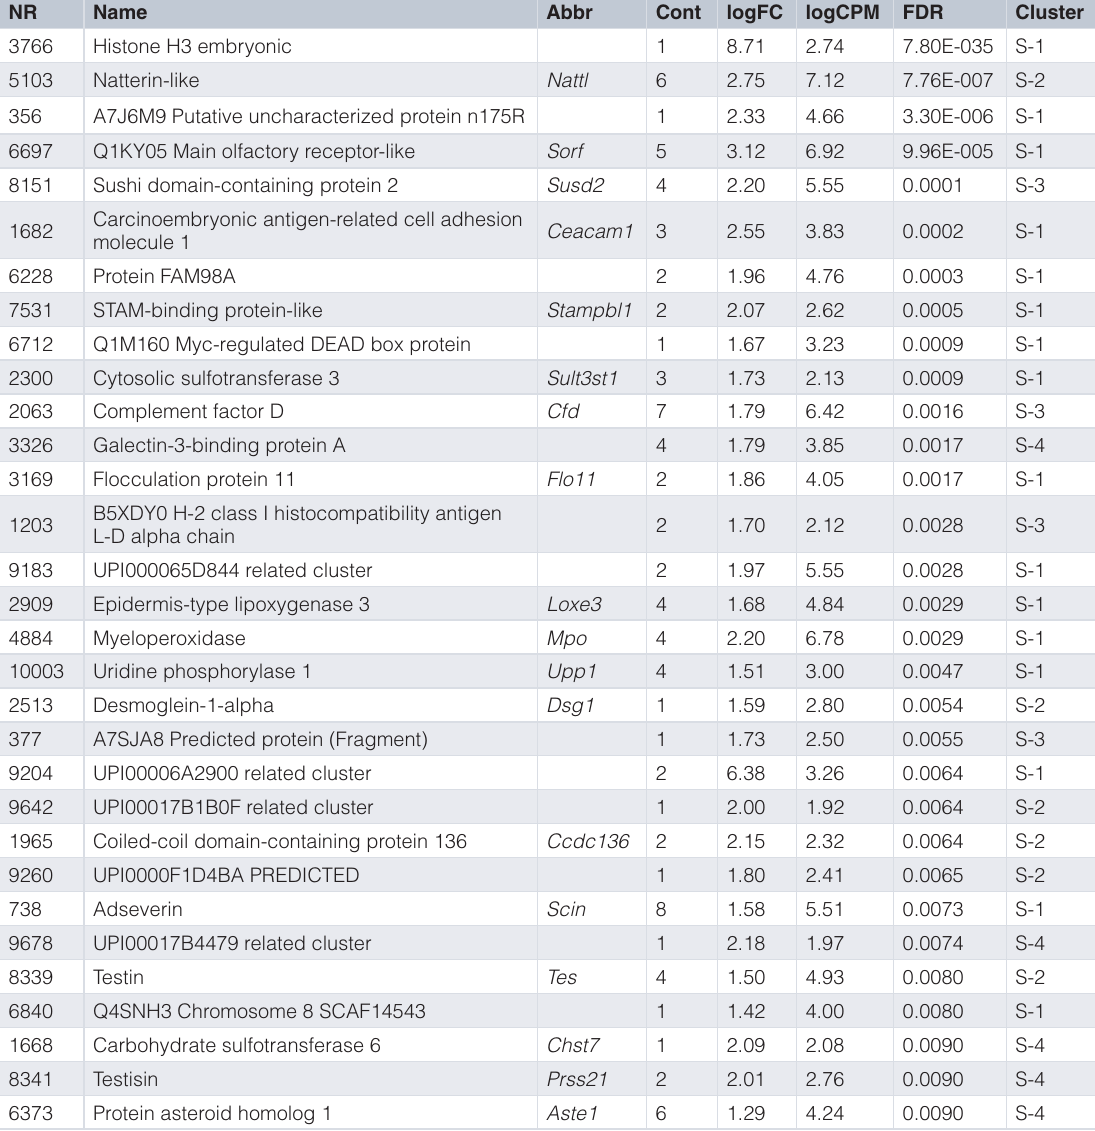
Table 1. Differentially expressed genes, with higher expression in the SB morph from Lake